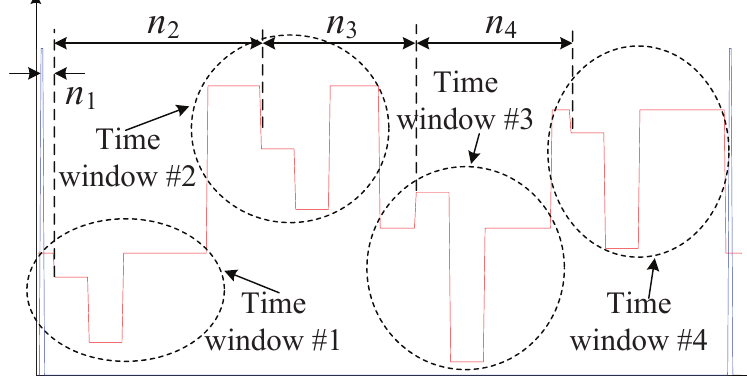
Figure 2. Time windows for a practical TDM sensor